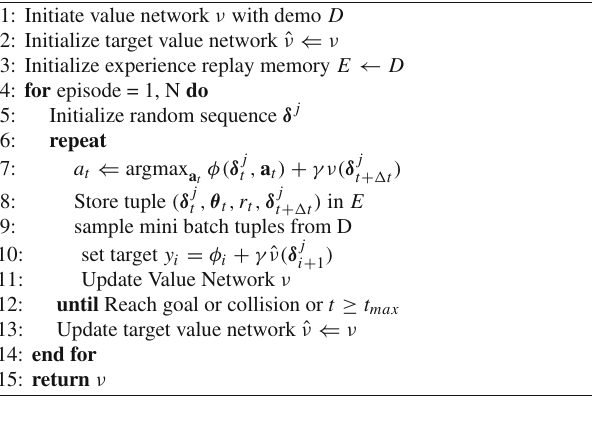
Algorithm 1 Value network learning